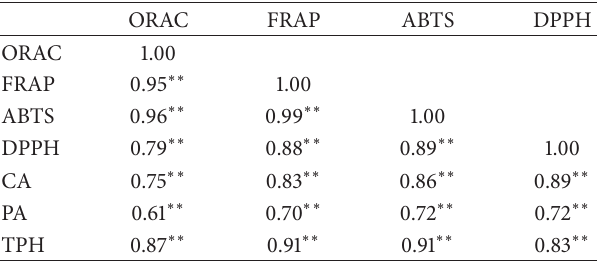
Table 3: Pearson’s correlation coefficients of antioxidant activities, phytic acid, total phenolics, total flavonoid content, and cinnamic